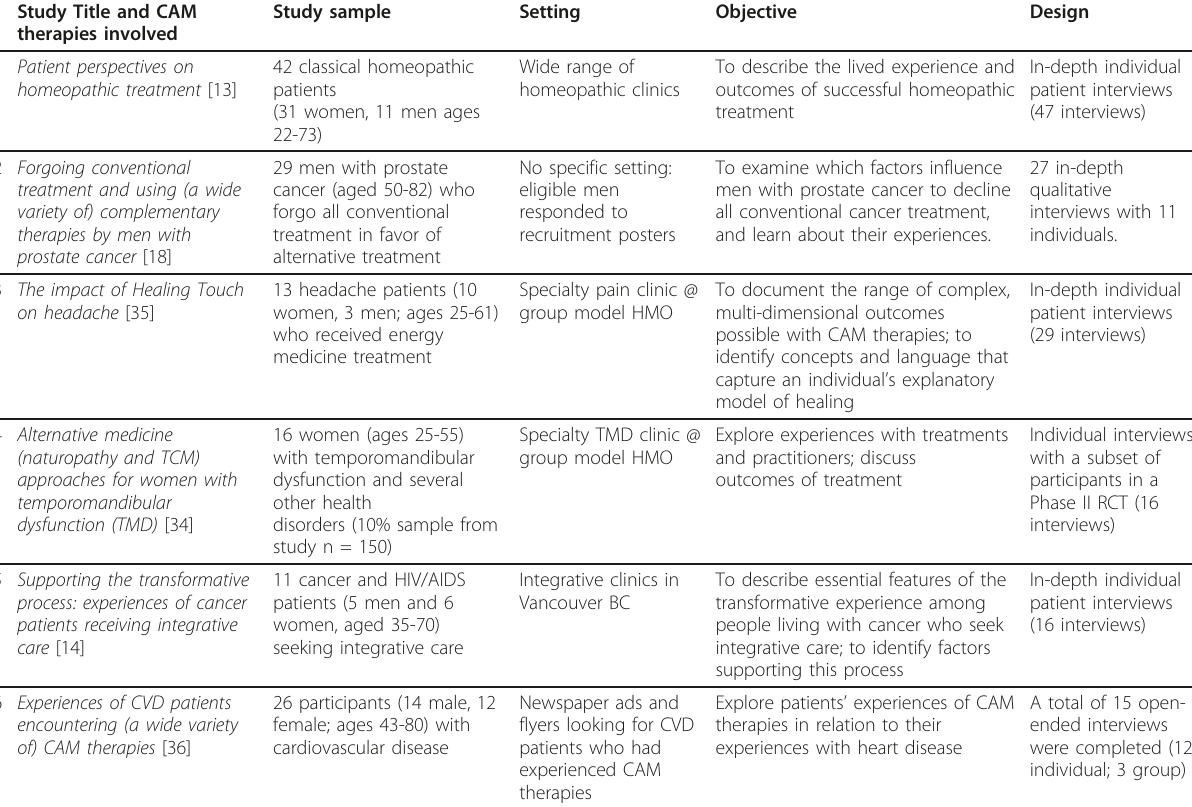
Table 1 Descriptions of original data